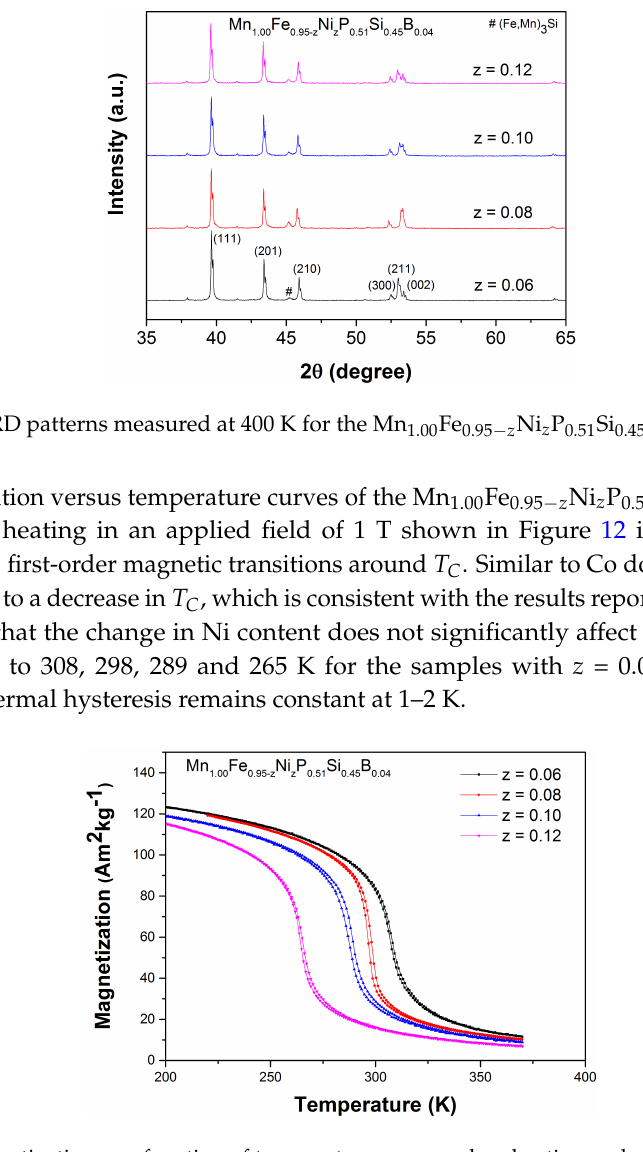
Figure 12. Magnetization as a function of temperature measured on heating and cooling in a magnetic field of 1 T for the Mn 1.00 Fe 0.95 − z Ni z P 0.51 Si 0.45 B 0.04 compounds. The applied sweep rate is 2